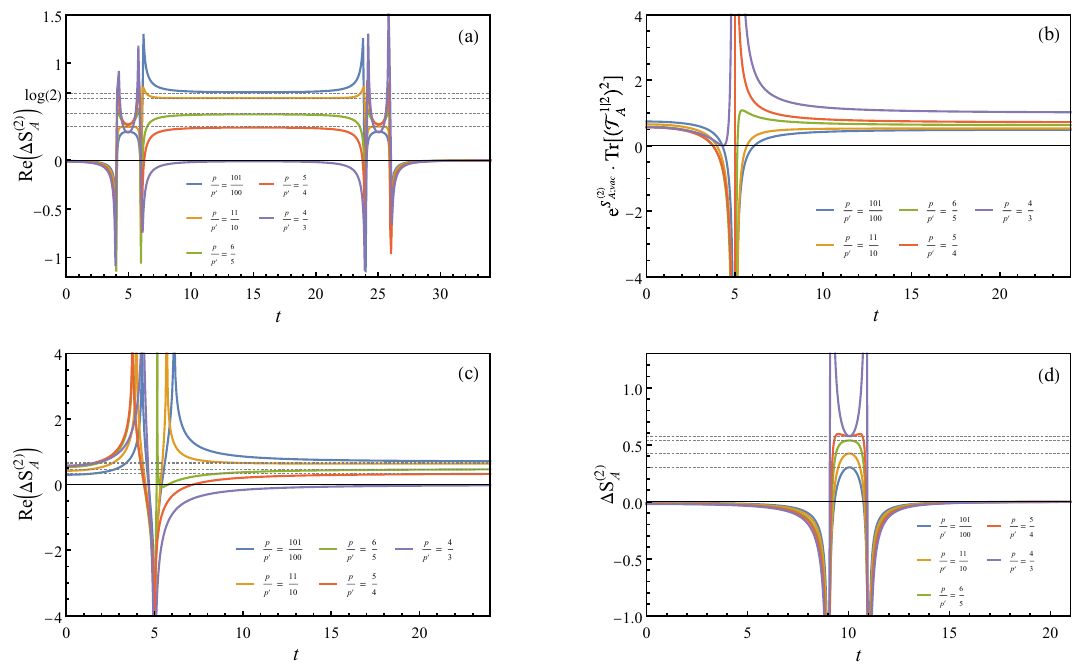
Figure 3. (a) and (c): the time evolution of Re [∆ S (2) ] under the φ -excitation in minimal (2 , 1) A models. The regulator is chosen to be (cid:15) = 10 − 5 . We have A = [0 , 20] , l = 2 , x m = − 5 for (a), and A = [0 , ∞ ) , x m = 0 , l = 10 for (c). The dashed lines correspond to log d for different p/p 0 ; (b): (2 , 1) (2) 1 | 2 the time evolution of e S ) 2 ] in the case of A = [0 , ∞ ) , where S (2) is the 2nd Rényi A ;vac · Tr [( T A A ;vac entropy of A when the total system is in the vacuum state. The parameters are selected as (cid:15) = 10 − 5 , x m = 0 , l = 10 ; (d): the time evolution of ∆ S (2) in the case of A = [0 , L ] . The parameters are A selected as L = 20 , (cid:15) = 10 − 5 , x m = 10 , l = 2 . ∆ S (2) ( η, ¯ η ) = ∆ S (2) (1 / 2 , 1 / 2) at the dashed lines. A A